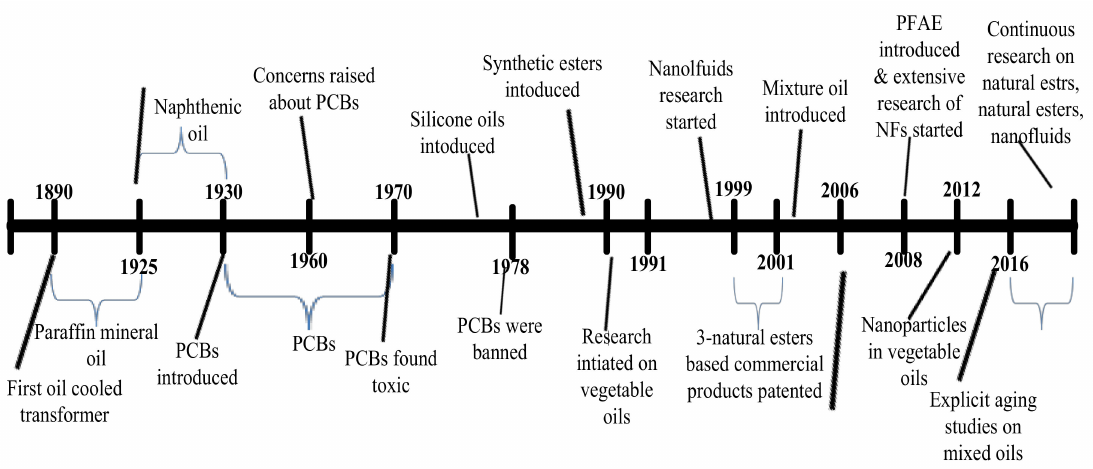
Figure 3. Timeline of research and development on insulating liquids for HV